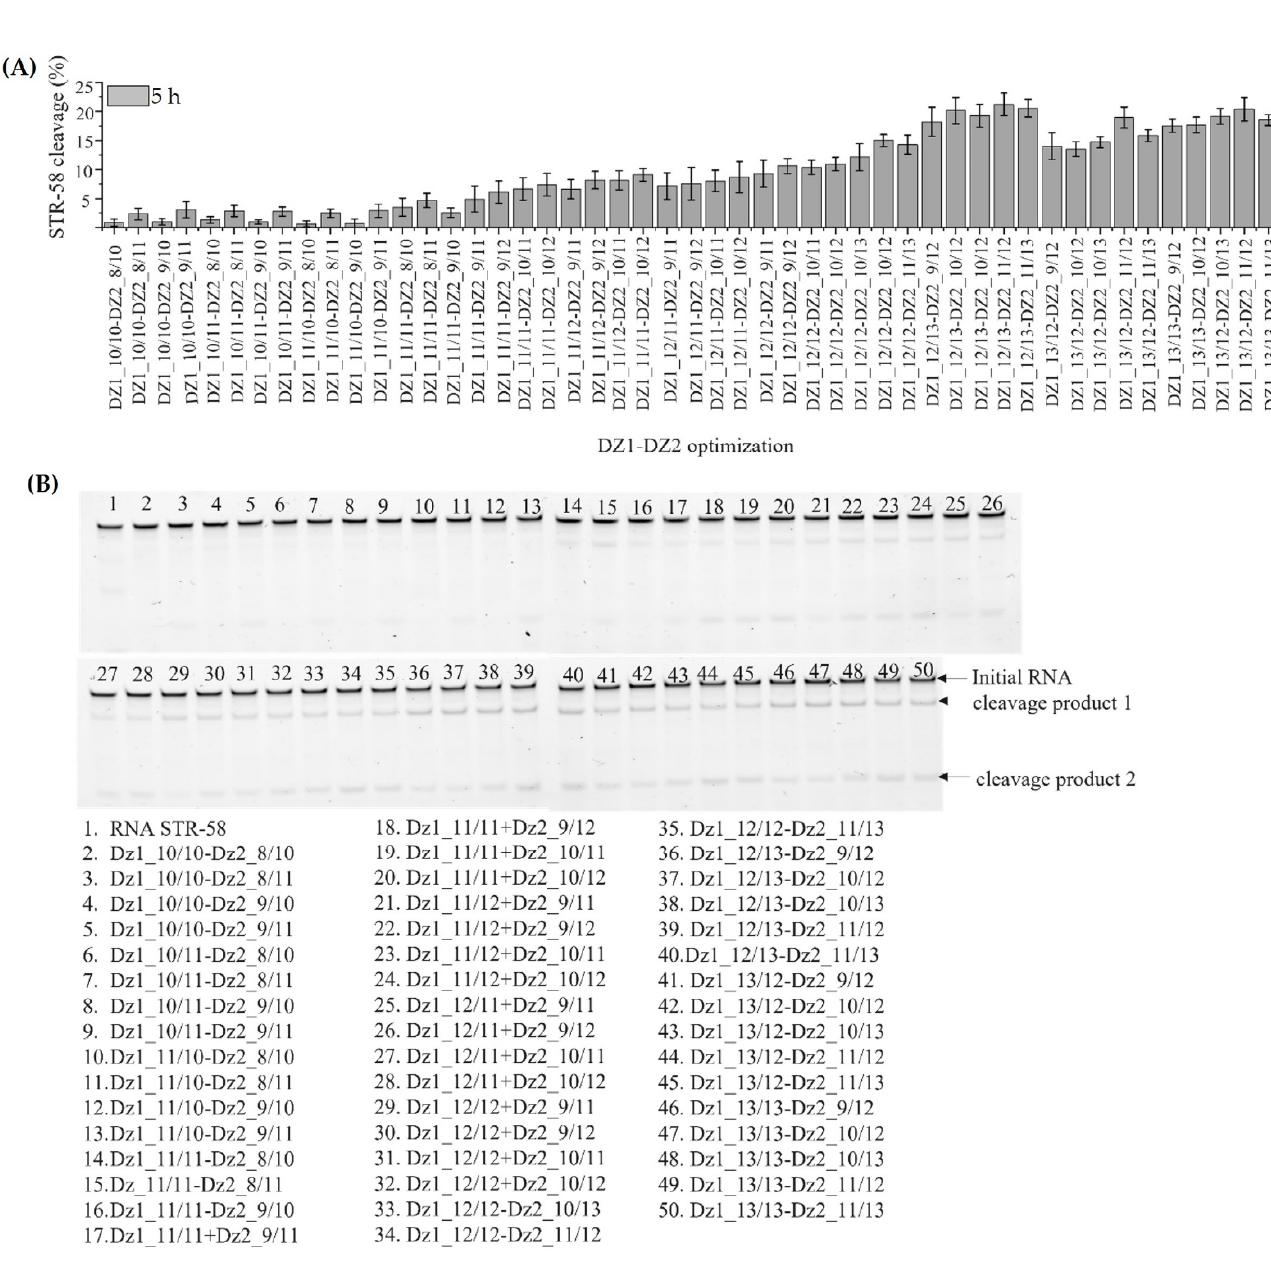
Figure 7. Optimization of Dz1-Dz2. ( A ) Results of Dz1-Dz2 optimization with varied binding arm length and melting temperature after 5 h of incubation. ( B ) PAGE electrophoresis of optimized Dz1-Dz2.